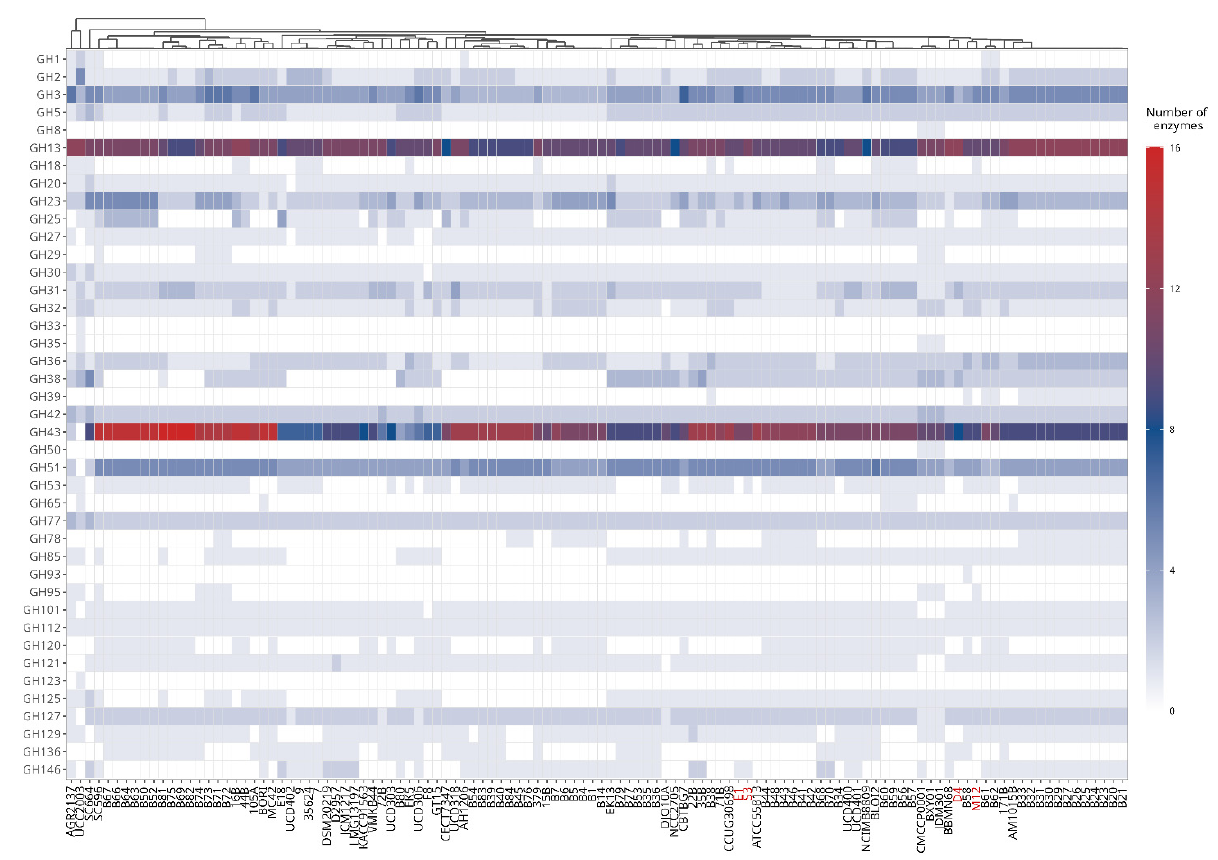
Figure 5. Heatmap displaying the predicted glycosyl hydrolases family members identified in B. longum subsp. longum genomes. Chilean strains are colored in red.